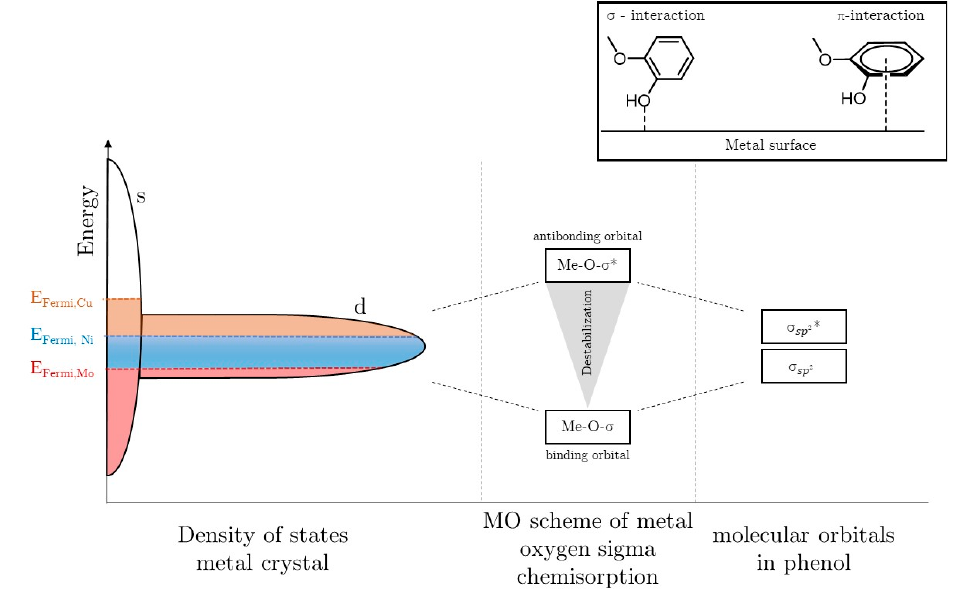
Figure 19. Schematic representation of the electron transfer from the metal into the binding ( δ ) and antibonding ( δ *) metal-oxygen orbital. The higher the center of the d-band, the stronger the transfer into the antibonding metal-oxygen orbital, which decreases the bond strength assuming a δ -bond. Visualization according to d-band model of Hammer and Nørskov [34,74,76].